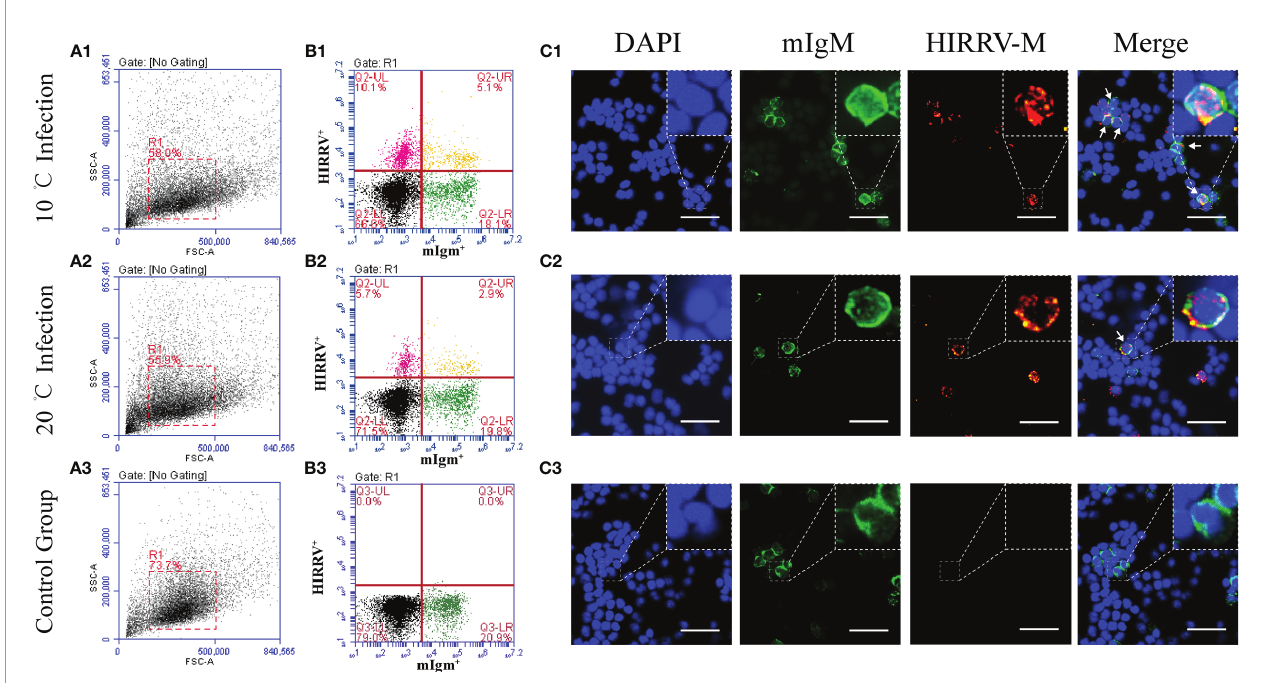
FIGURE 1 | Infection characteristics of HIRRV to mIgM + B lymphocytes at 10°C and 20°C. The proportions of HIRRV + /mIgM + B lymphocytes (24 hpi) detected by fl ow cytometry and IIFA. (A) Flow cytometry results of B lymphocytes in peripheral blood leukocytes. FSC area (FSC-A)/SSC area (SSC-A) analyses are shown in (A1 – A3) , and the red gate represents leukocytes. (B) HIRRV + /mIgM + B lymphocytes. Mouse anti- fl ounder IgM mAbs and Mouse anti-HIRRV M protein mAbs were used in this experiment. (C) Immuno fl uorescence staining results of HIRRV + /mIgM + B lymphocytes. (1), 10°C infection; (2), 20°C infection; (3), Control Group. Arrows indicate HIRRV + /mIgM + B lymphocytes, Bar = 20 m